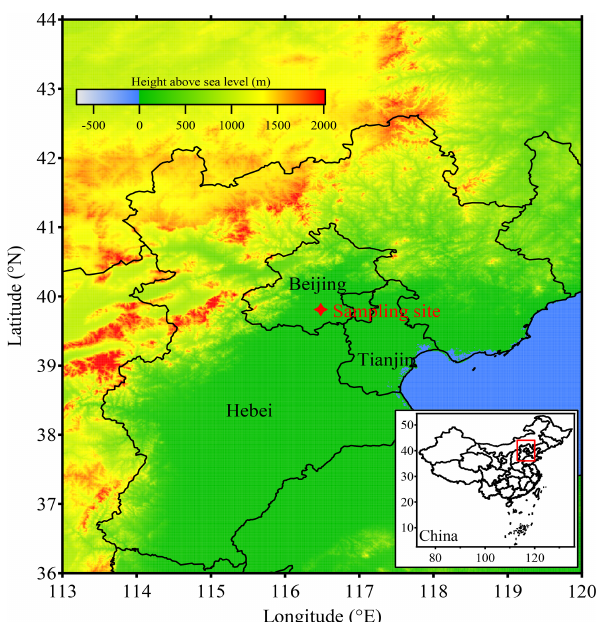
Figure 1. Map showing the Beijing–Tianjin–Hebei region in China and the location of the experiment site. The colored background shows the terrain height (unit: ma.s.l. – above sea